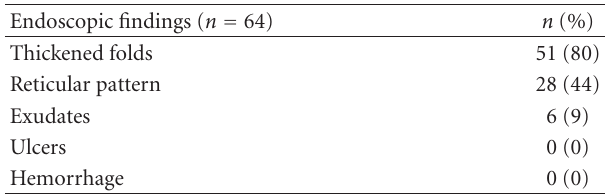
Table 2: Endoscopic findings of the greater curvature of the gastric body after spraying Lugol’s iodine